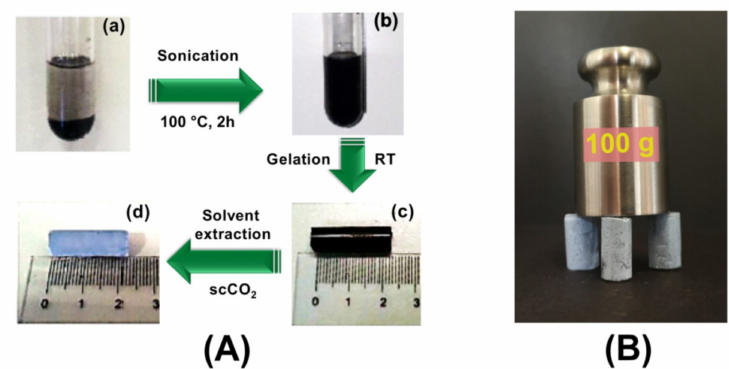
Figure 2. ( A ) Preparation procedure for monolithic polymer / r-GO aerogel: dispersion of GO into an organic solvent before ( a ) and after ( b ) sonication at 100 ◦ C for 2 h in step one; ( c ) stable self-standing gel formed after adding the polymer to the dispersion of GO and the dissolution of the polymer at high temperature; ( d ) monolithic aerogel of polymer / r-GO nanocomposites fabricated by supercritical carbon dioxide (scCO 2 ) extraction of gels obtained in step two. ( B ) Three syndiotactic polystyrene (sPS) / r-GO aerogel pillars (porosity = 90%) supporting 100